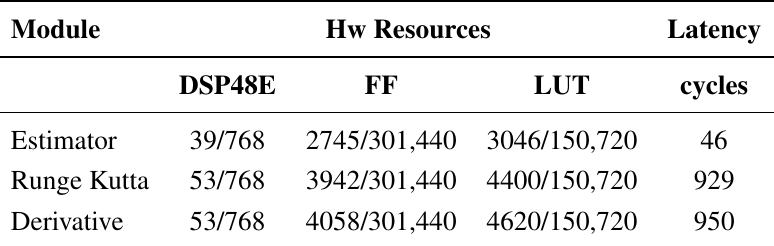
Table 2. Synthesis